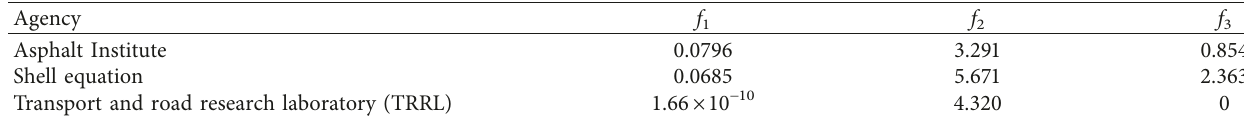
Table 3: Coefficients for determining the cracking life.